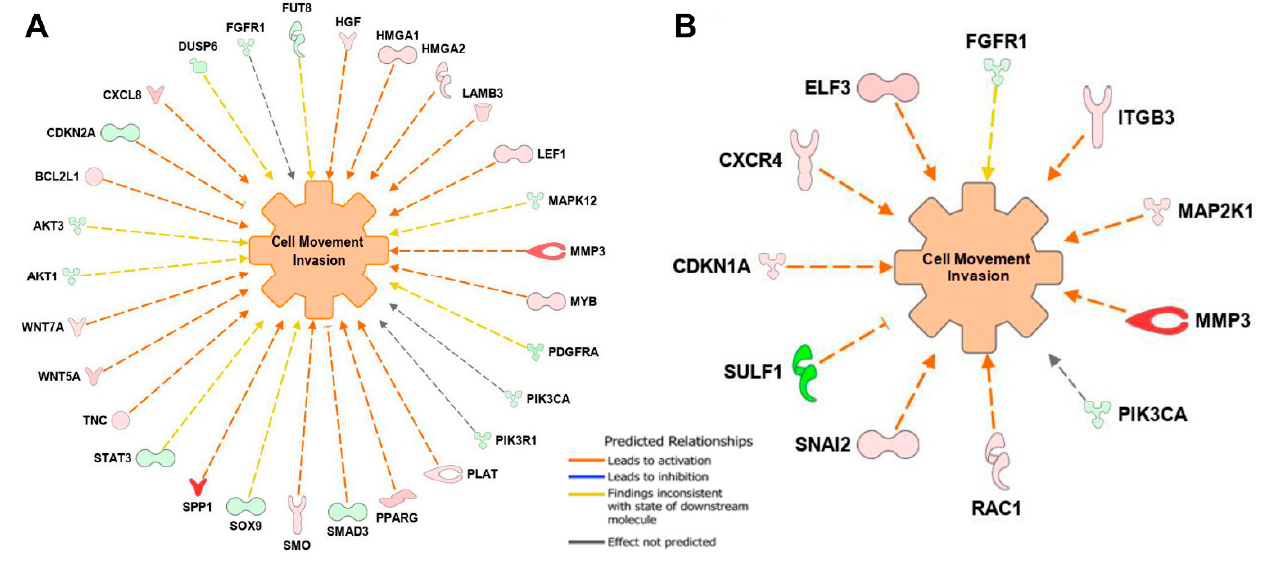
Figure 8. IPA predicted that Cd exposure stimulated migration and invasion in CRLM6 cells based on the directions of the gene expression changes. ( A ). IPA function analysis derived from the PanCancer Pathways panel dataset (z-score 2.30). ( B ). IPA functions analysis derived from the PanCancer Progression panel dataset (z-score 2.35). The dashed lines with an arrow indicate that upregulation of gene expression is predicted to promote cell movement. The dashed lines with a T-bar demonstrate that downregulation of gene expression is predicted to promote cell movement.